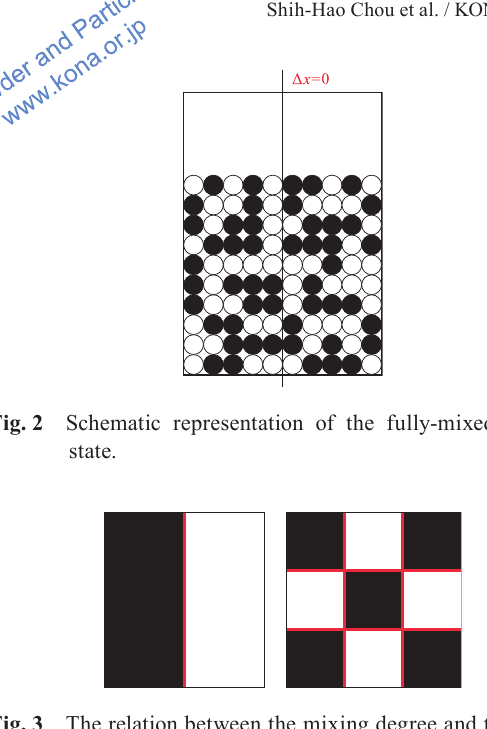
Fig. 3 The relation between the mixing degree and the length of the boundary between two different species.